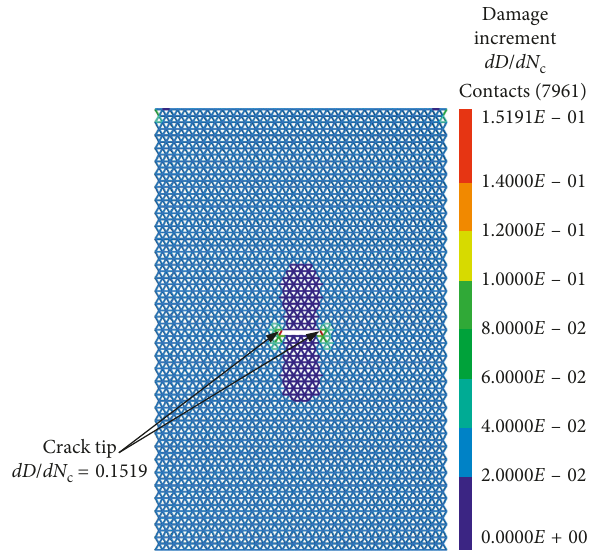
Figure 11: Damage increment per cycle of a center cracked